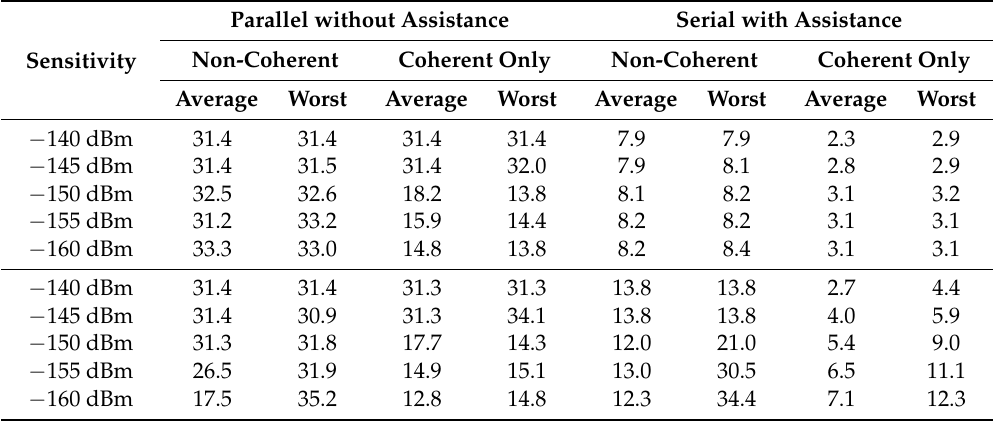
Table 21. Ratio of number of frequency bins between the E5 and E1 signals.